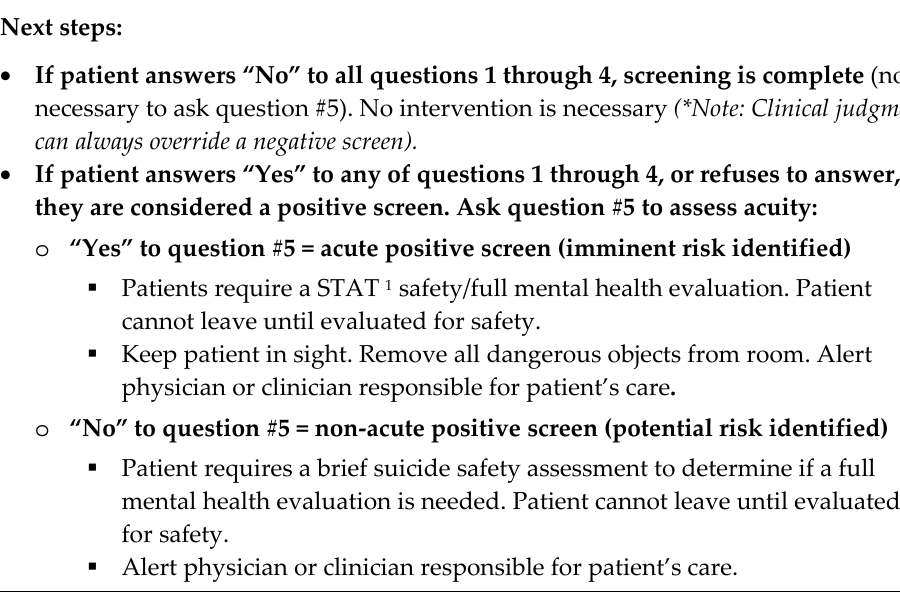
Figure 2. Ask Suicide-Screening Questions (ASQ). Reproduced with permission from Dr Lisa M. Horowitz, Arch Ped Adolesc Med, published by JAMA Network, 2012 [67].